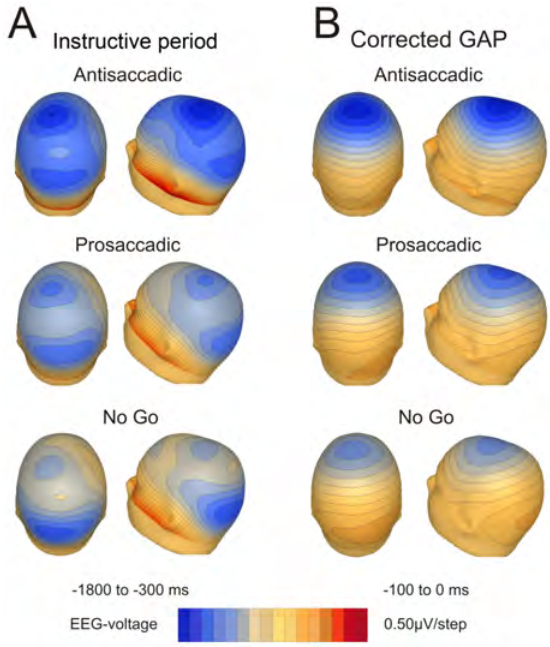
Figure 5. Voltage topographies. The scalp voltage distribution during the instructive period (A) displayed fronto-central and posterior negativity. The topography during the last 100 ms of the gap period, after subtracting the trend line during the instructive period, showed the fronto-central but not the occipital component (B).